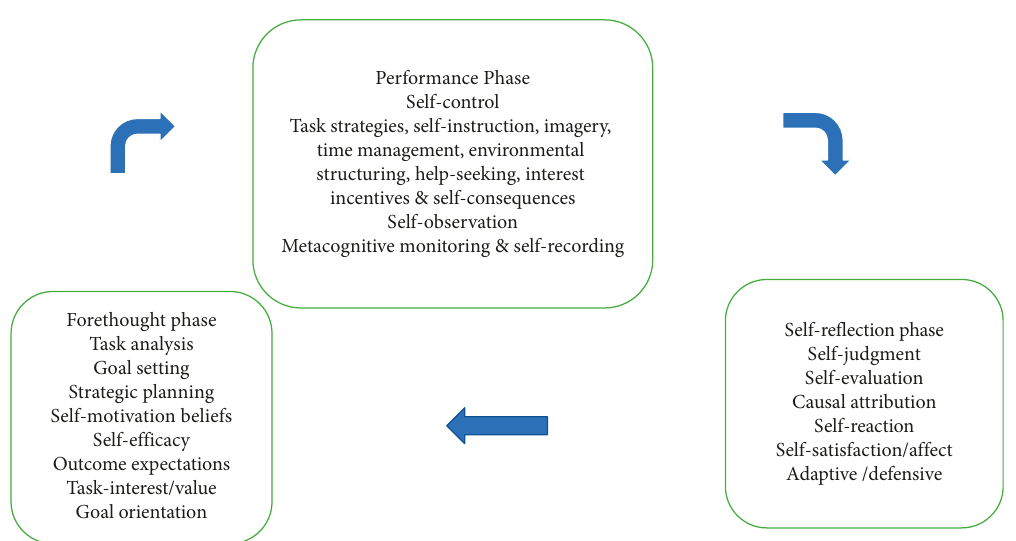
Figure 1: Phases and processes of self-regulation according to Zimmerman and Moylan